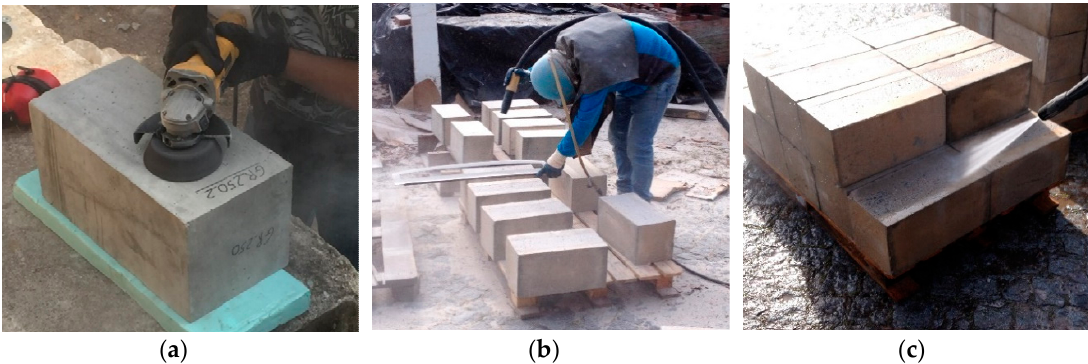
Figure 2. Concrete surface preparation: ( a ) grinding; ( b ) sandblasting; ( c ) surface cleaning.